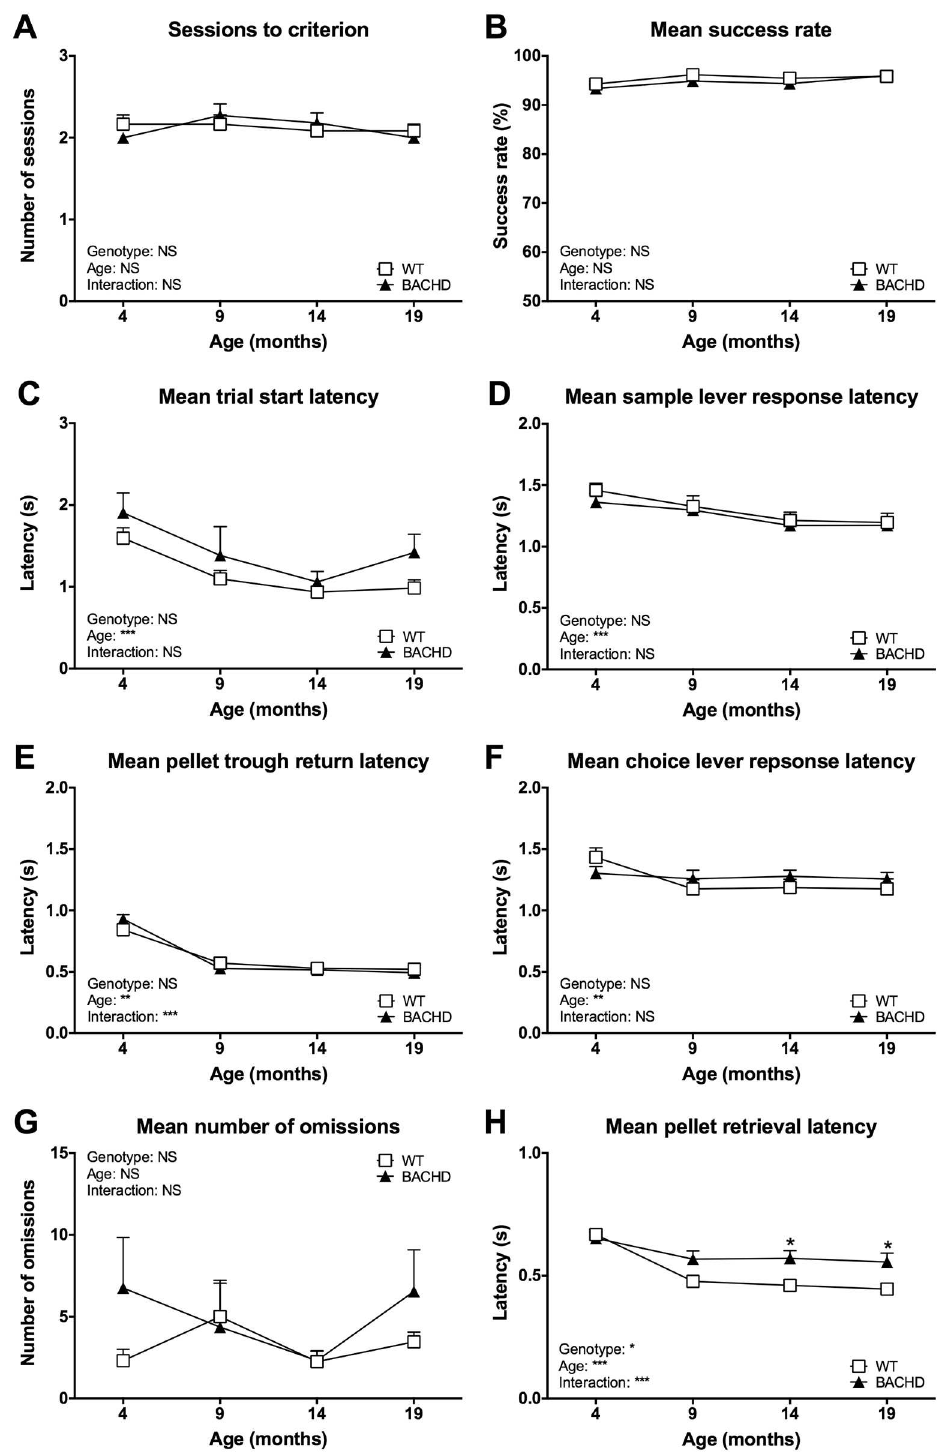
Fig 6. Age development of free non-matching to position performance. The graphs show the main readoutsof the free non-matching to positionprotocol over the four test ages. (A) shows the number of trainingsessionsrequiredfor reaching criterion. (B)–(H) show the mean performanceof rats duringsessions where their success rate was at criterion level. Sessionto criterion data was corrected for the changein criterion betweenthe first test age and retesting. Curves show group mean plus standarderror. Results